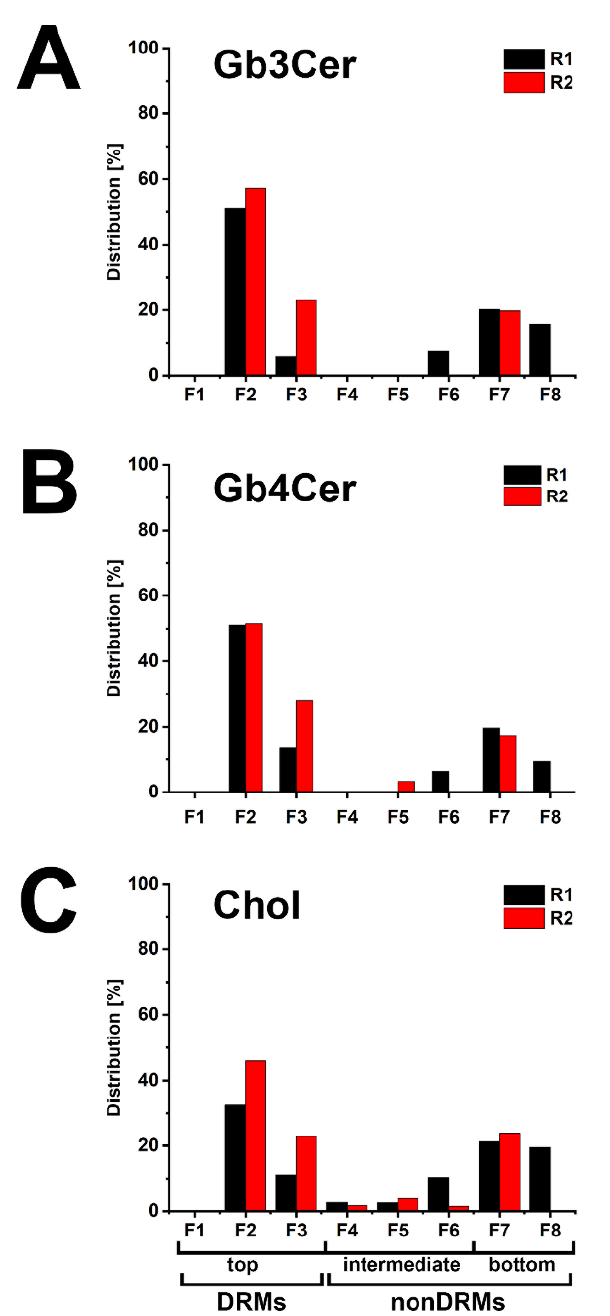
Figure 6. Portrayal of the distribution of Gb3Cer ( A ), Gb4Cer ( B ) and cholesterol ( C ) among sucrose gradient fractions F1 to F8 obtained from pHCoEpiCs. The anti-Gb3Cer and anti-Gb4Cer detected immunopositive GSL bands and the manganese(II)chloride-stained cholesterol bands shown in Figure 5 were scanned and normalized to 100% for each distribution pattern of Gb3Cer, Gb4Cer and cholesterol compiled for the two independent biological replicates (R1 and R2). A list of measured values is provided in Table S1 of the Supplementary Materials.